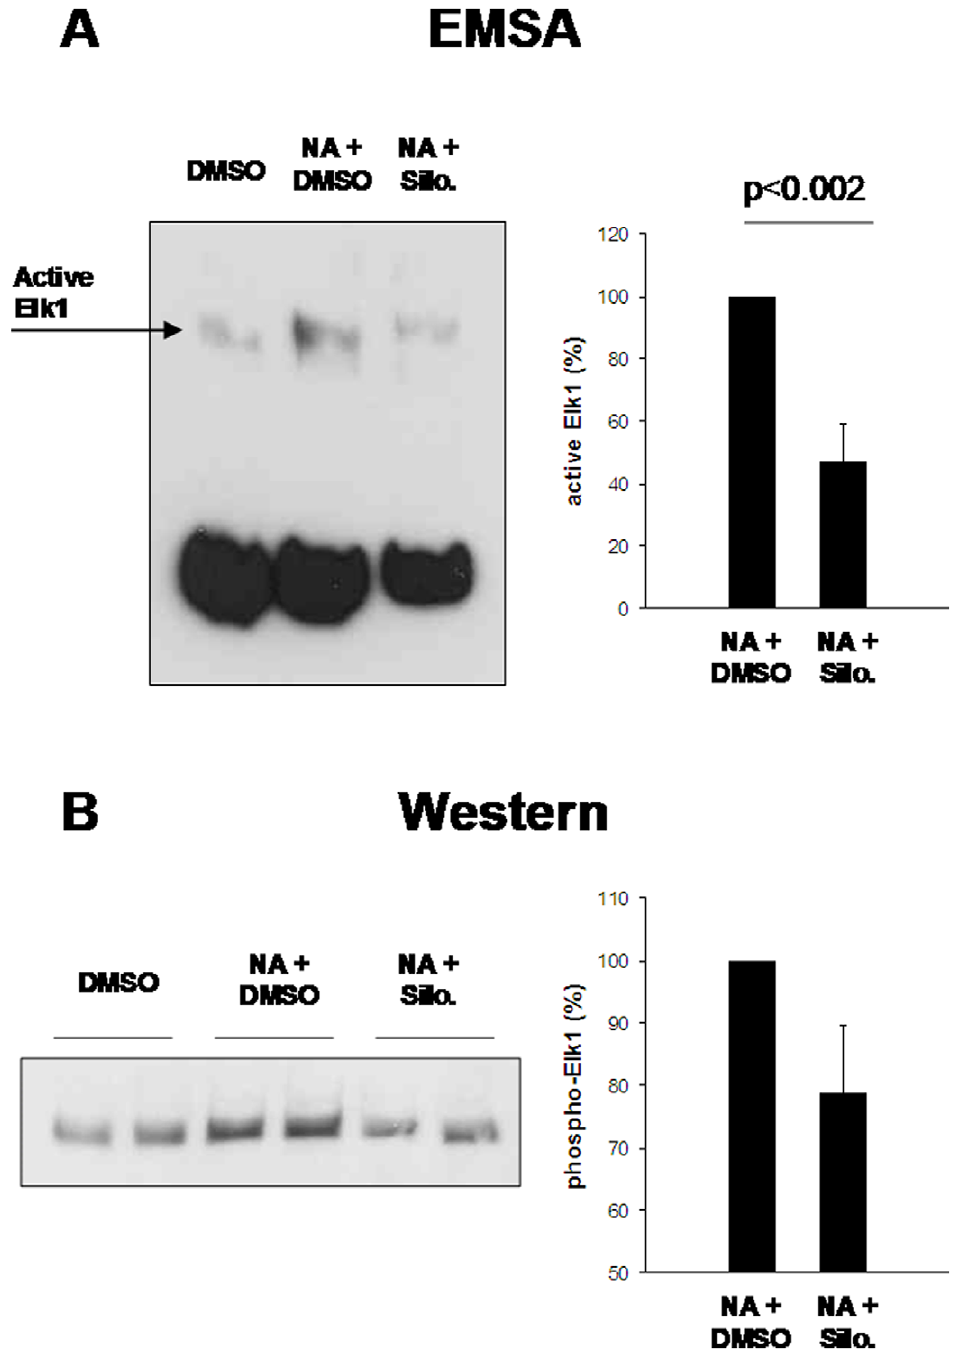
Figure 5. Inhibition of NA-induced Elk1 activation by silodosin. Prostate tissue from each patient was allocated to three samples, which were stimulated with NA (30 m M) for 15 min, or remained unstimulated. Silodosin (3 m M) or solvent (3 m l DMSO) were added 15 min before NA as indicated. All samples were exposed for identical total periods to experimental conditions to prevent agonist-unspecific effects. In each experiment, Elk1 in NA-stimulated samples without silodosin (= DMSO) was set to 100%, and values for samples with silodosin were referred to that sample. ( A ) Inhibition of Elk1 activity by silodosin in NA-stimulated prostate samples (n=6 patients), detected by EMSA. ( B ) Inhibition of Elk1 phosphorylation by silodosin in NA-stimulated prostate samples (n=6 patients), assessed by Western blot analysis. Shown are representative experiments, and densitometric quantification of all experiments (means 6 SEM). doi:10.1371/journal.pone.0050904.g005 Our study was performed in tissues from patients undergoing peripheral zone [16,17]. Almost all patients undergoing radical radical prostatectomy. We used non-malignant tissue from the prostatectomy show prostate hyperplasia. Therefore, normal, non- hyperplastic tissue was not available for our study, and our findings periurethral zone, while most prostate tumors are located to the